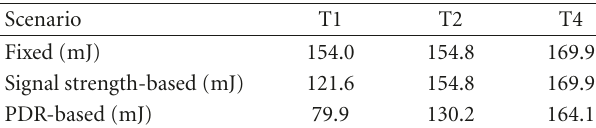
Table 3: Quantitative comparison for the energy consumption of IEEE